Question: Name the type of graph shown.
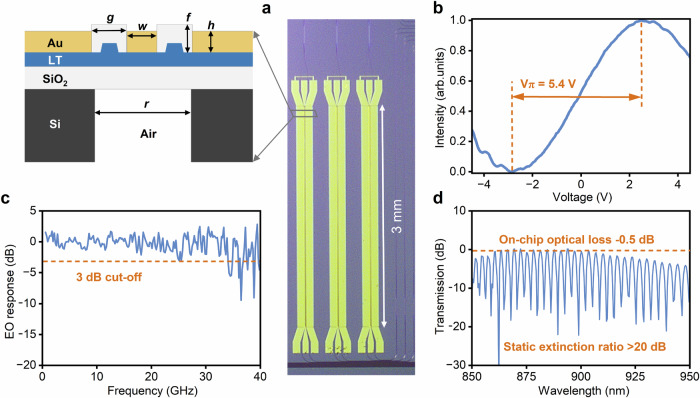
Answer: line